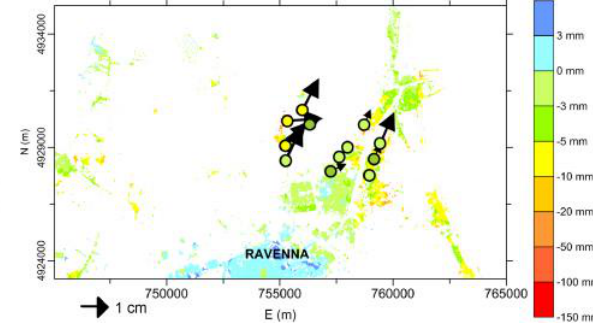
Table 3. Comparison between the displacement time-series obtained with SBAS (dots) and CPT (lines).